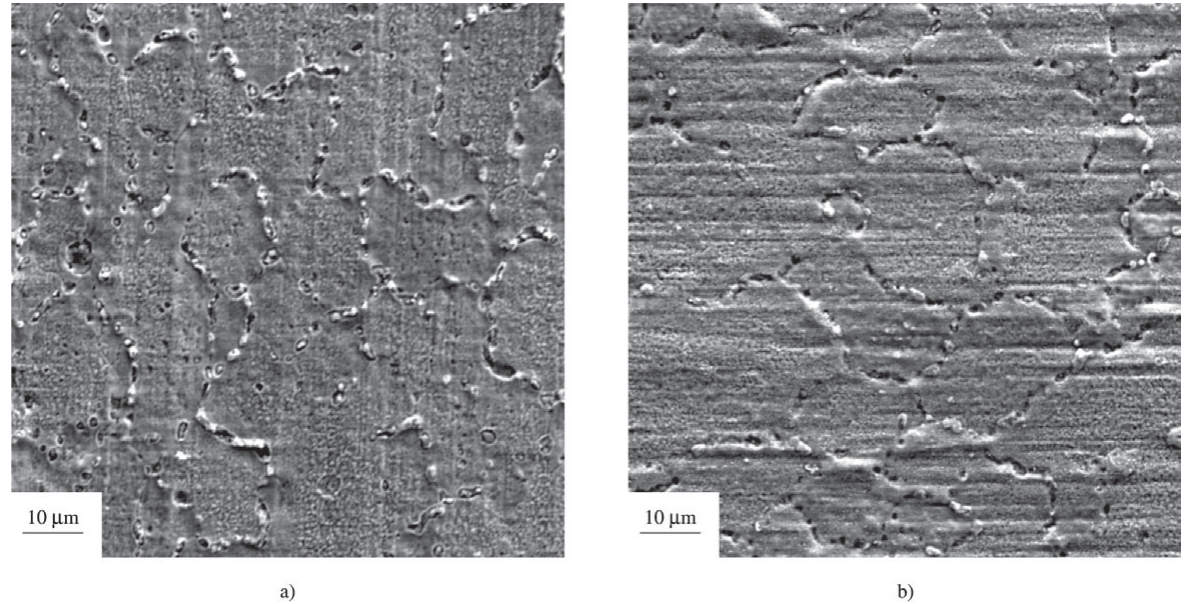
Figure 8. Metal side (left) and oxide side (right) of the Cr substrate (after 150 cycles at 850 °C).